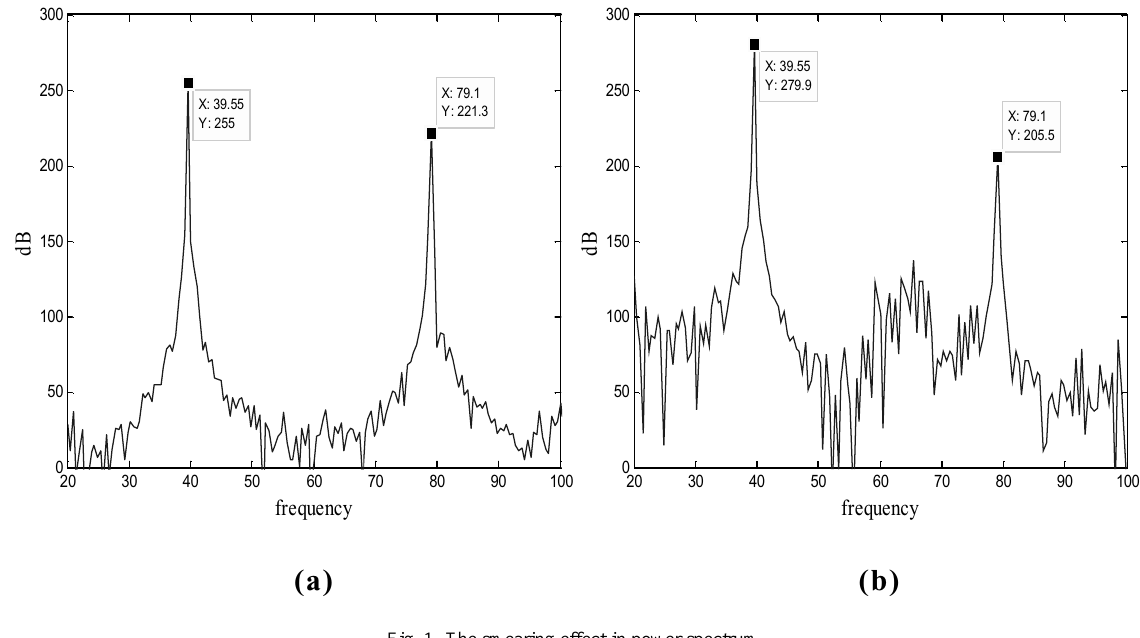
Fig. 1. The smearing effect in power